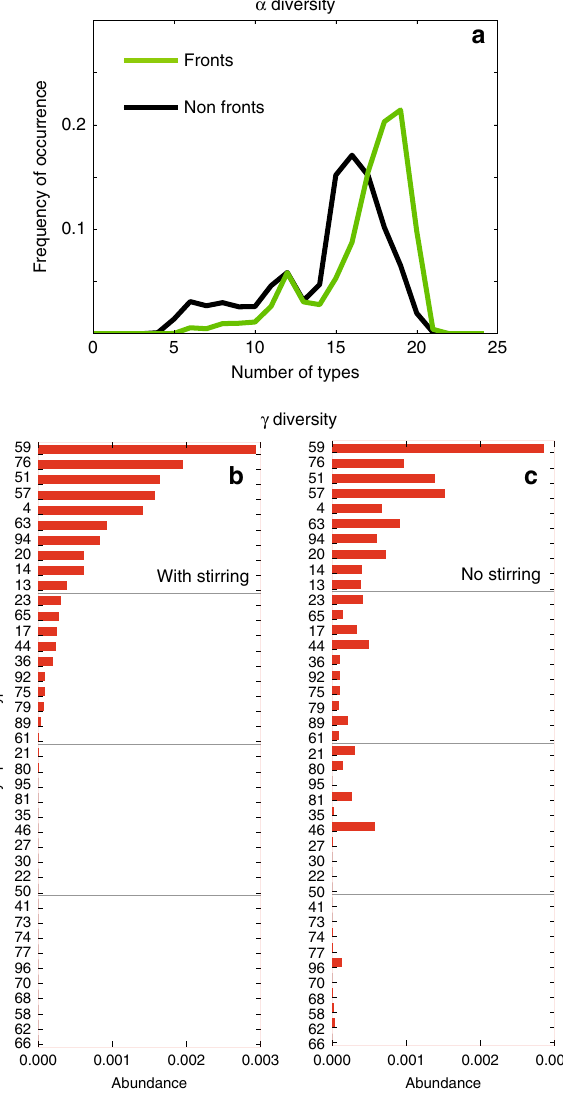
Fig. 6 α -plankton and γ -plankton diversity. a The distribution of phytoplankton α -diversity over fronts (green) and away from fronts (black). Higher number of types demonstrates the increased coexistence of phytoplankton at fronts. Shown are outputs from the Darwin model comprising 100 phytoplankton types embedded in the high-resolution submesoscale fl ow shown in Box 3. In this model, the community structure is not imposed; rather it “ self-assembles ” according to the relative fi tness of the phytoplankton types. The consequence is that at each time step, each model grid point is characterized by a speci fi c community of plankton and α -diversity. b The abundances of the phytoplankton types that emerged over the entire region with the same simulation (with stirring) and c in a simulation without stirring. Stirring was suppressed by embedding the phytoplankton model in the annual time-mean fl ow instead of the submesoscale fl ow. Without stirring, the community contained more different types with more even abundances, thus the γ -diversity was larger. Thus at a local level there were more types over fronts (more α -diversity); at the regional level the stirring decreased the number of coexisting types (less γ -diversity). Adapted from Lévy et al.